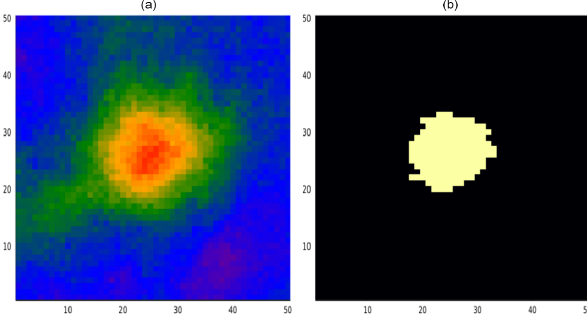
Figure 6. Illustration case. Panel (a) shows the mineralization z(x) of the example case. Panel (b) shows the massive ore mass of the mineral field i(x)